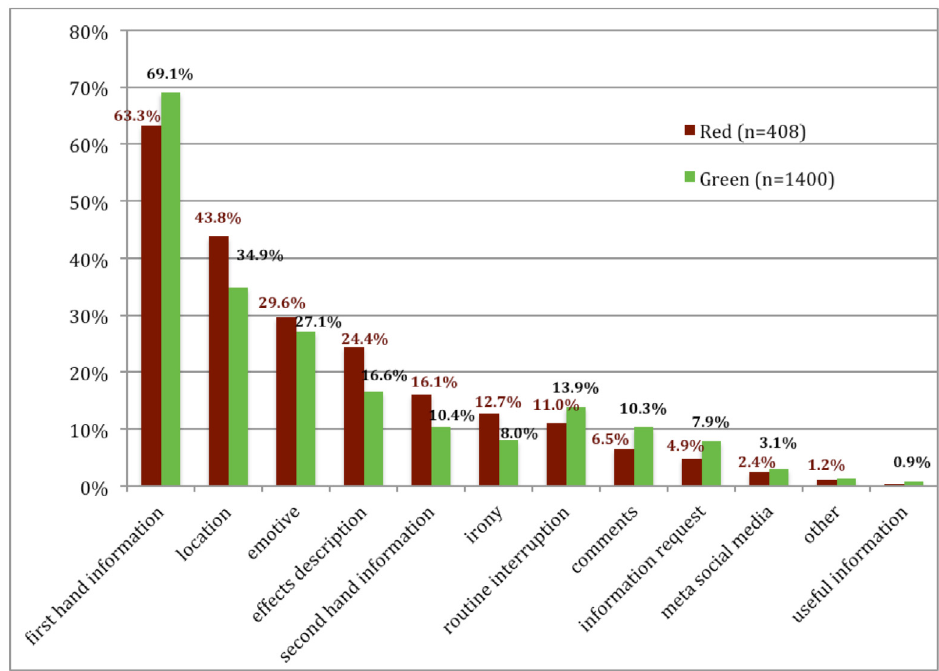
Figure 9. Tweet content categories according to tweets localization (May 20, 2012, 2:03 a.m.-4:02 a.m.